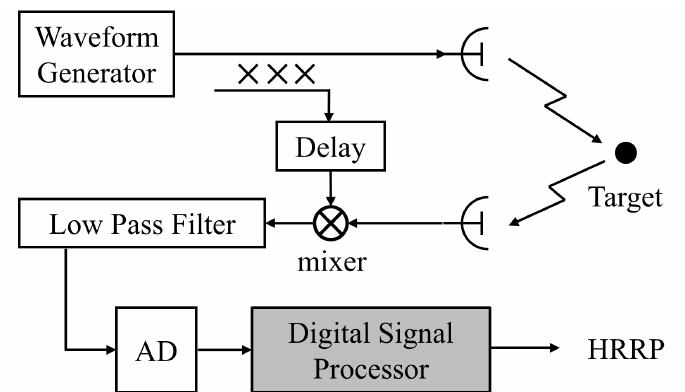
Figure 1. The existing LFM radar